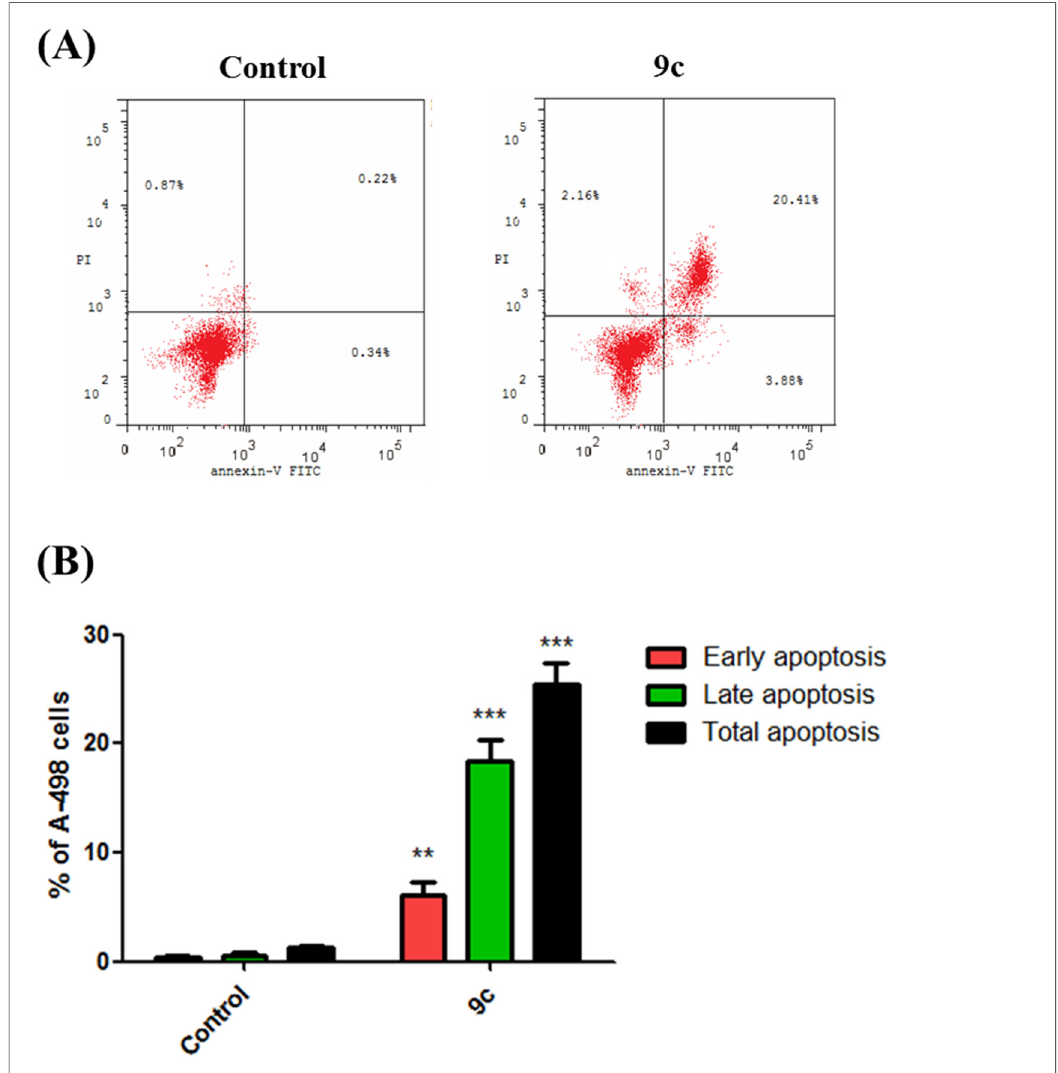
Figure 5. Compound 9c potently induces apoptosis in kidney carcinoma cell line A-498 cells (Annexin V/PI FACS). ( A ) Effect of compound 9c in A-498 cells analyzed by flow cytometry after double staining of the cells with Annexin-V-FITC and PI. A-498 cells treated with 6 μ M (approximately IC 50 value) of compound 9c for 48 h and collected and processed for analysis. ( B ) Quantitative analysis of apoptosis. Values represent the mean ± SEM for three independent experiments. Statistical